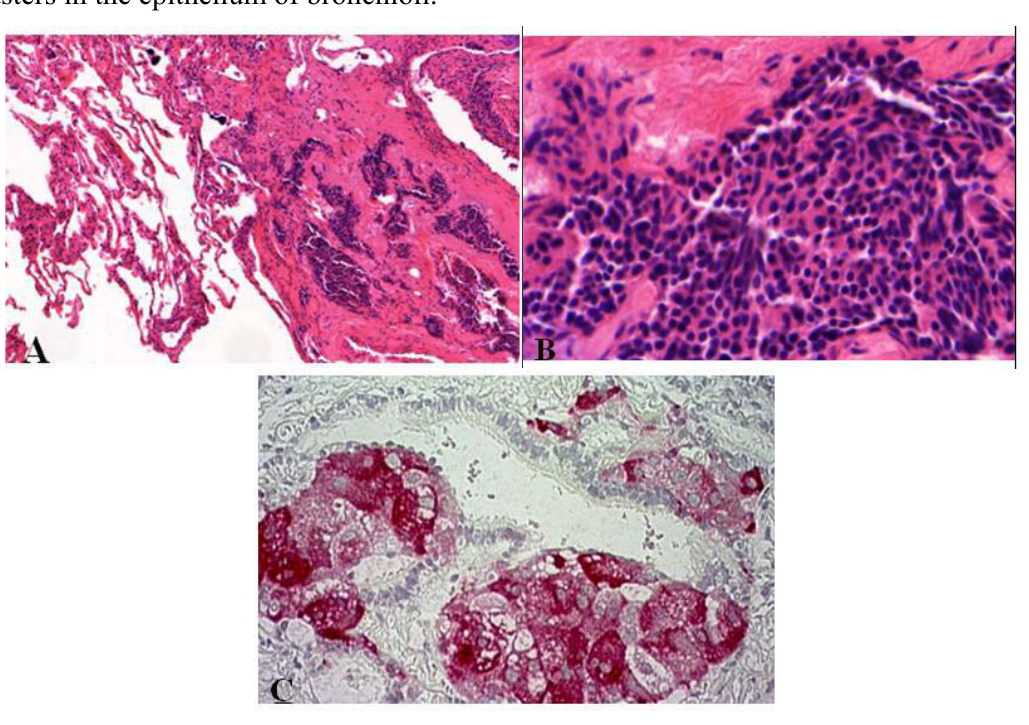
nodule aggregates within fibrotic tissue. Small cells with elongated or round nuclei without mitoses or nuclear atypia; ( C ) Synaptophysin stained small nodules of neuroendocrine cell clusters in the epithelium of